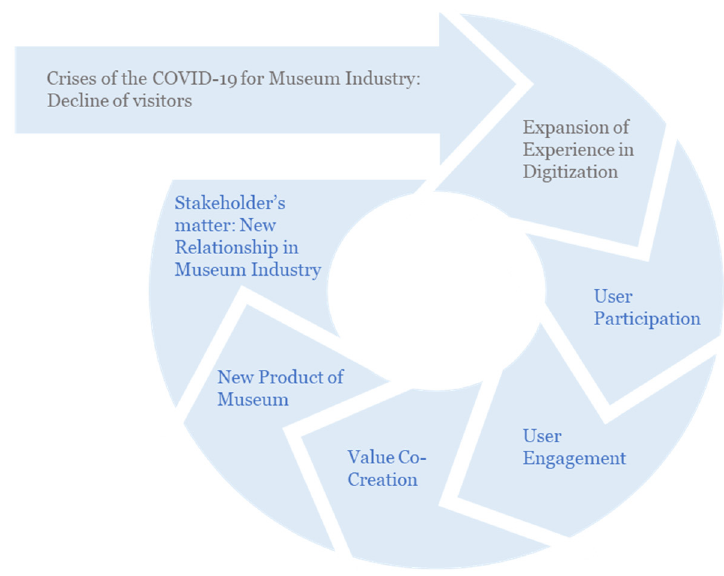
Figure 1. The conceptual framework.